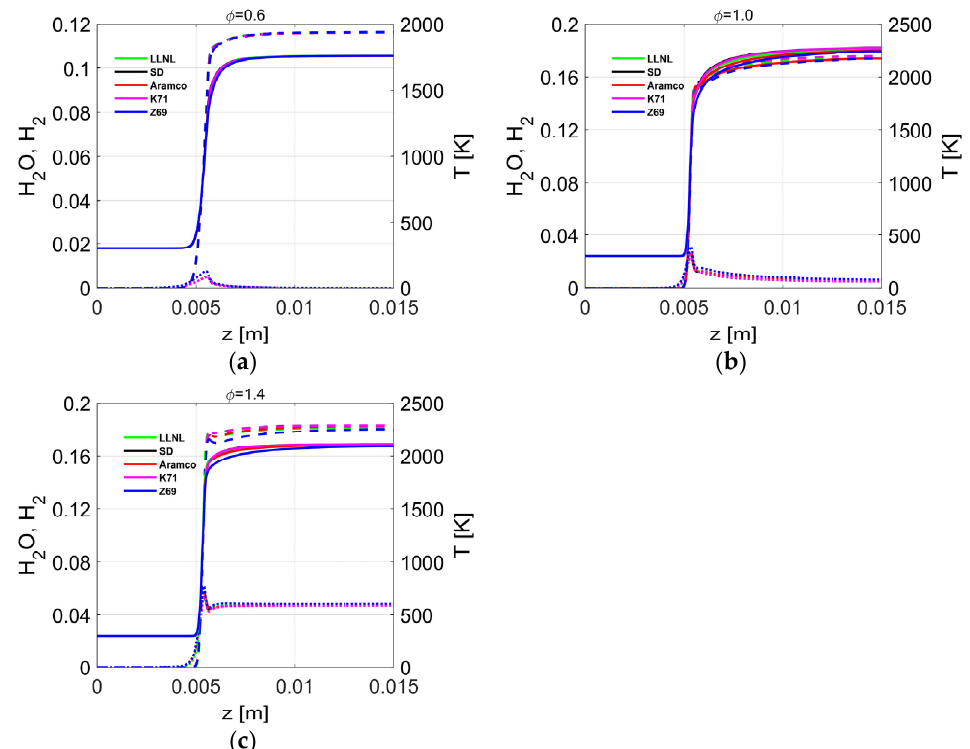
Figure A3. Flame profiles showing the flame temperature (solid line) and major species concentra- tions, H 2 O (dashed line) and H 2 (dotted line), at standard conditions of 1 atm and 300 K. Three equivalence ratios are shown with ϕ = 0.6 in ( a ), ϕ = 1.0 in ( b ) and ϕ = 1.4 in ( c ). Legend: mechanism predictions from Z69 in blue, LLNL in green [28], Aramco in red [17], K71 in magenta [32] and San Diego in black [30].